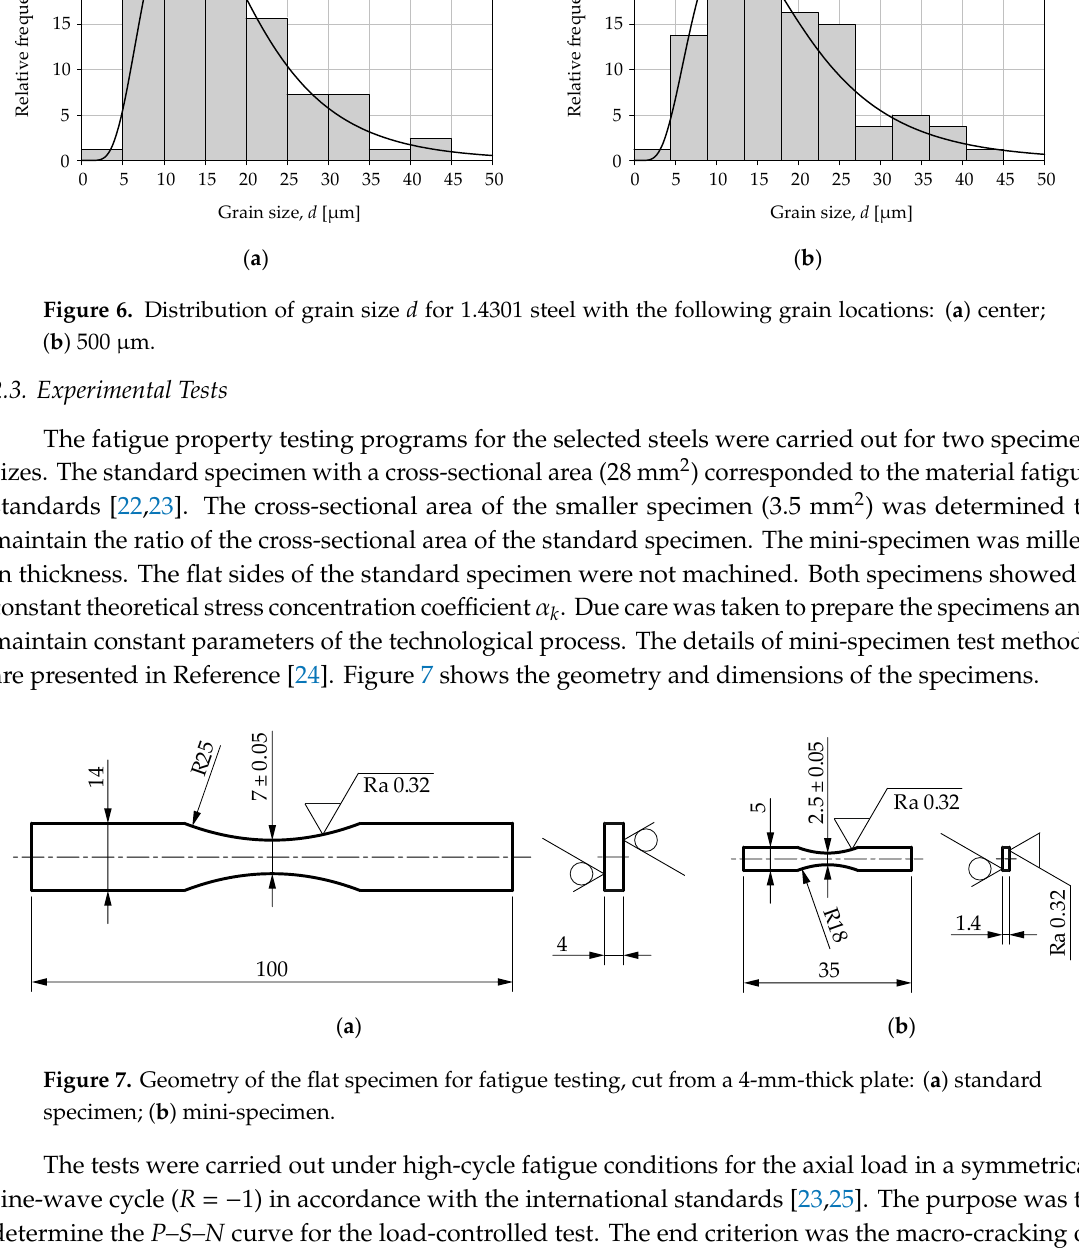
Figure 5. Distribution of grain size d for S235JR steel with the following grain locations: ( a ) center; ( b ) 500 µm.